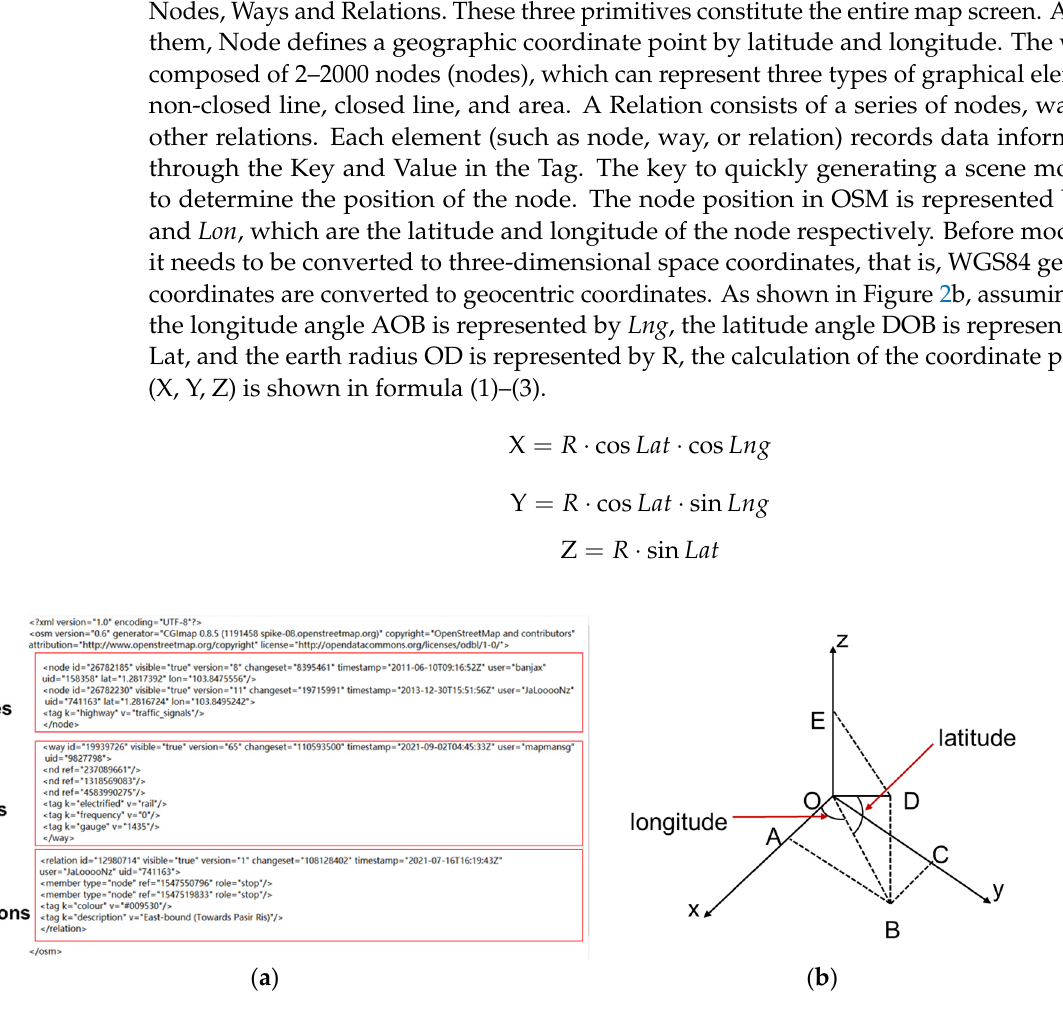
Figure 2. OSM file parsing. ( a ) OSM file format, ( b ) Coordinate transformation. The whole process of the proposed model generation method is shown in Figure